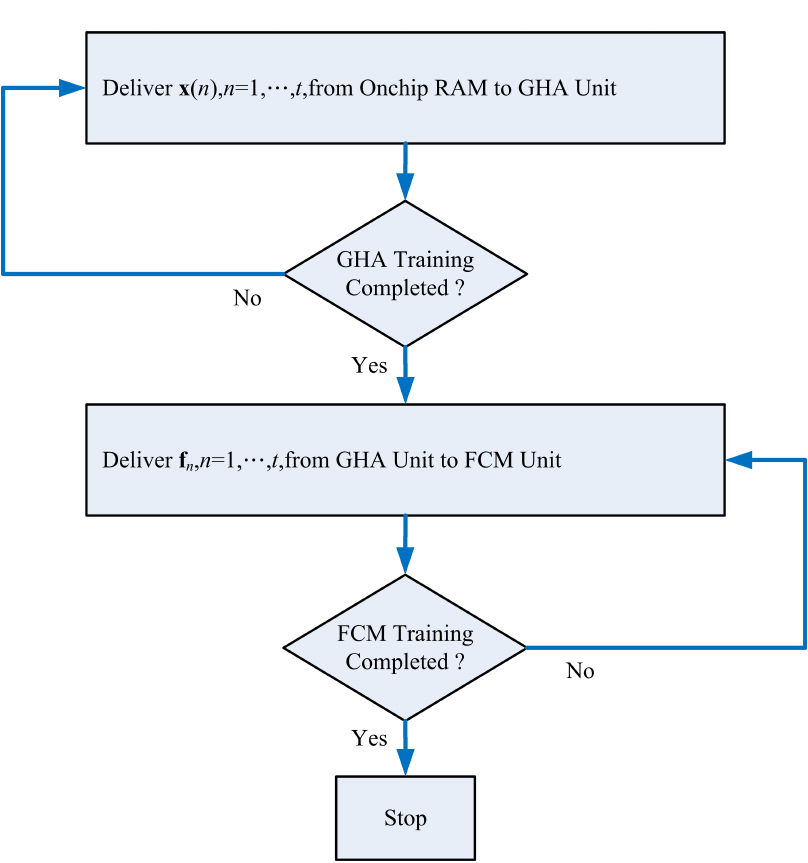
Figure 10. The state diagram of the global